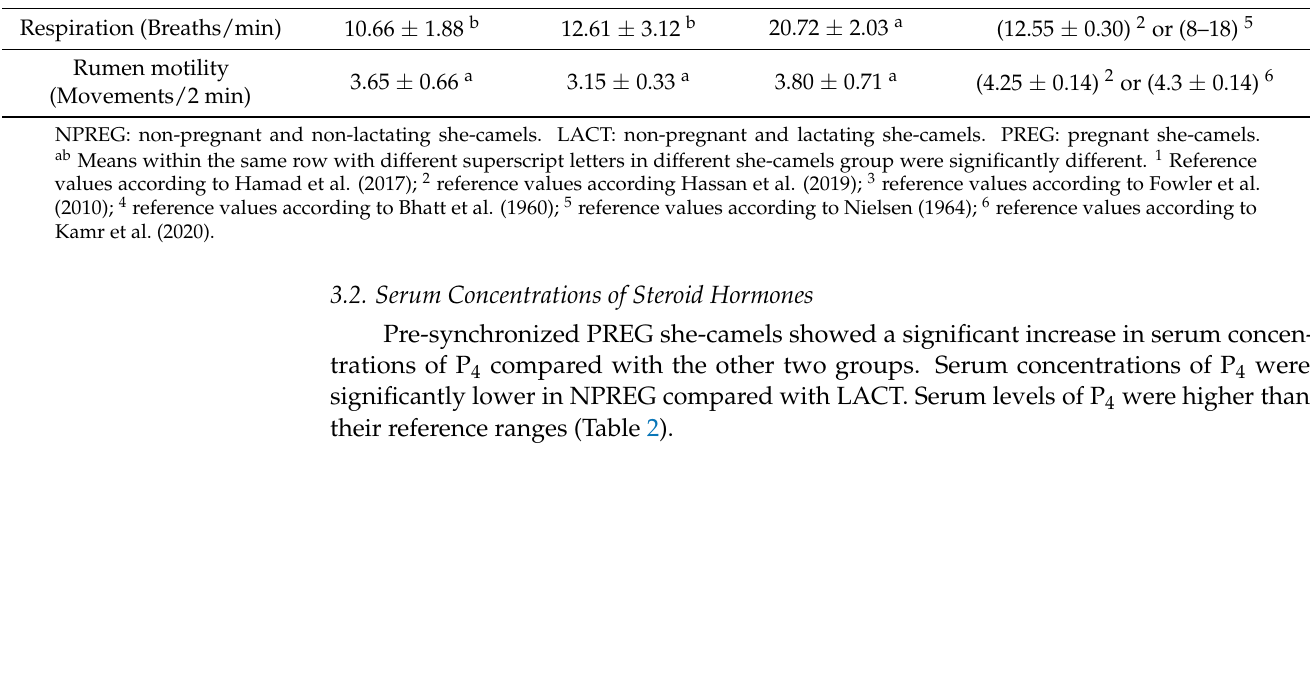
Table 1. Mean values (M ± SD) of temperature, pulse, respiration and rumen movements in non-pregnant non-lactating ( n = 14), non-pregnant lactating ( n = 8) and pregnant ( n = 38) she-camels. NPREG LACT PREG Reference Values Temperature ( ◦